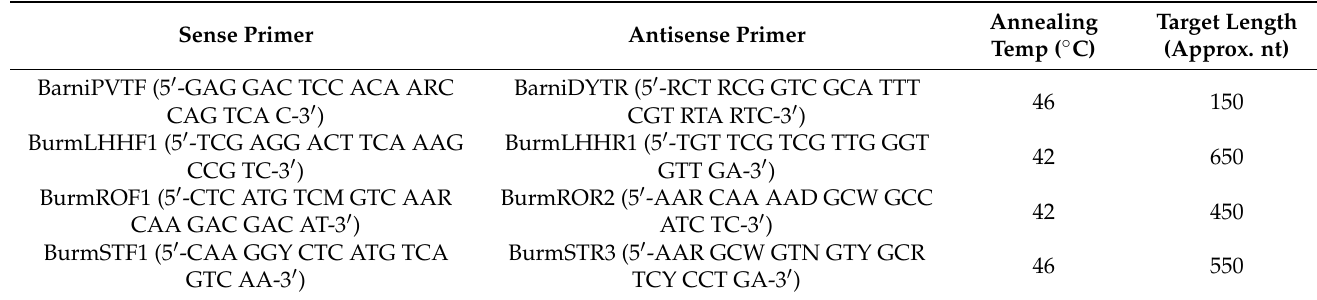
Table 2. Primers used for reverse transcription PCR (rtPCR) targeting novel Burmese python serpen- toviruses in Florida, USA with annealing temperature and target amplicon